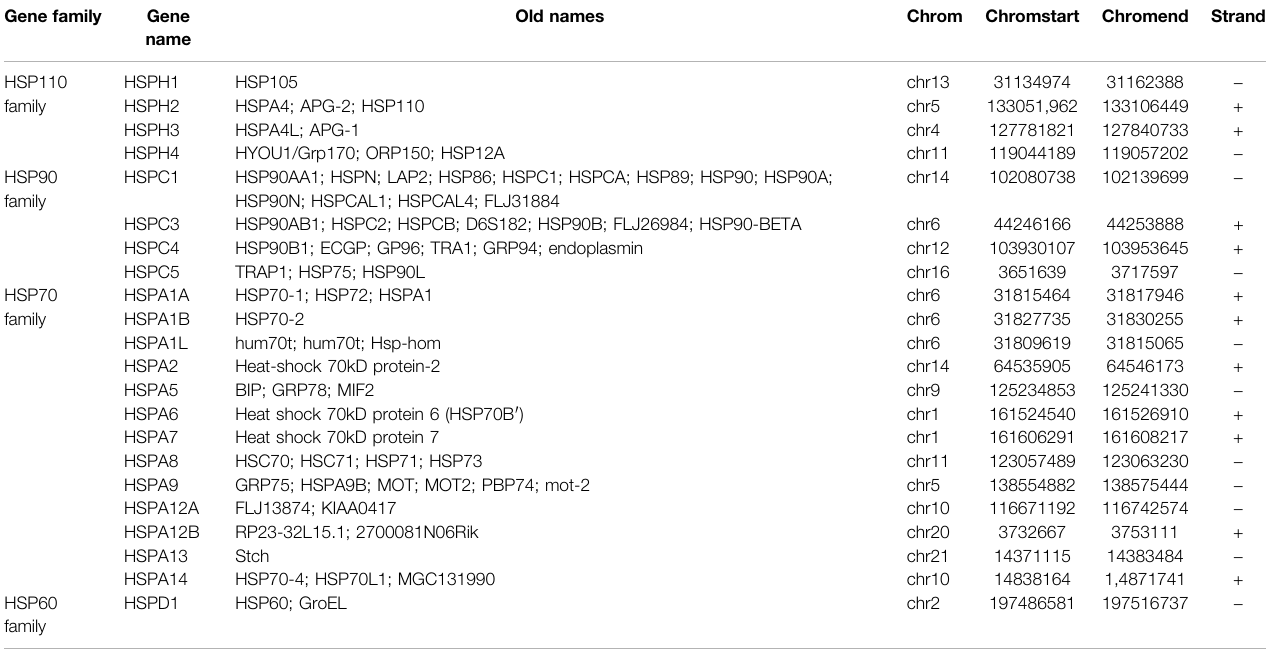
Table S1 . SPSSv25.0 (IBM, SPSS, and Chicago, IL, United States) and GraphPad Prism V8.0 (GraphPad software, United States) were utilized to perform data analysis, and 2 − Δ Ct was used to